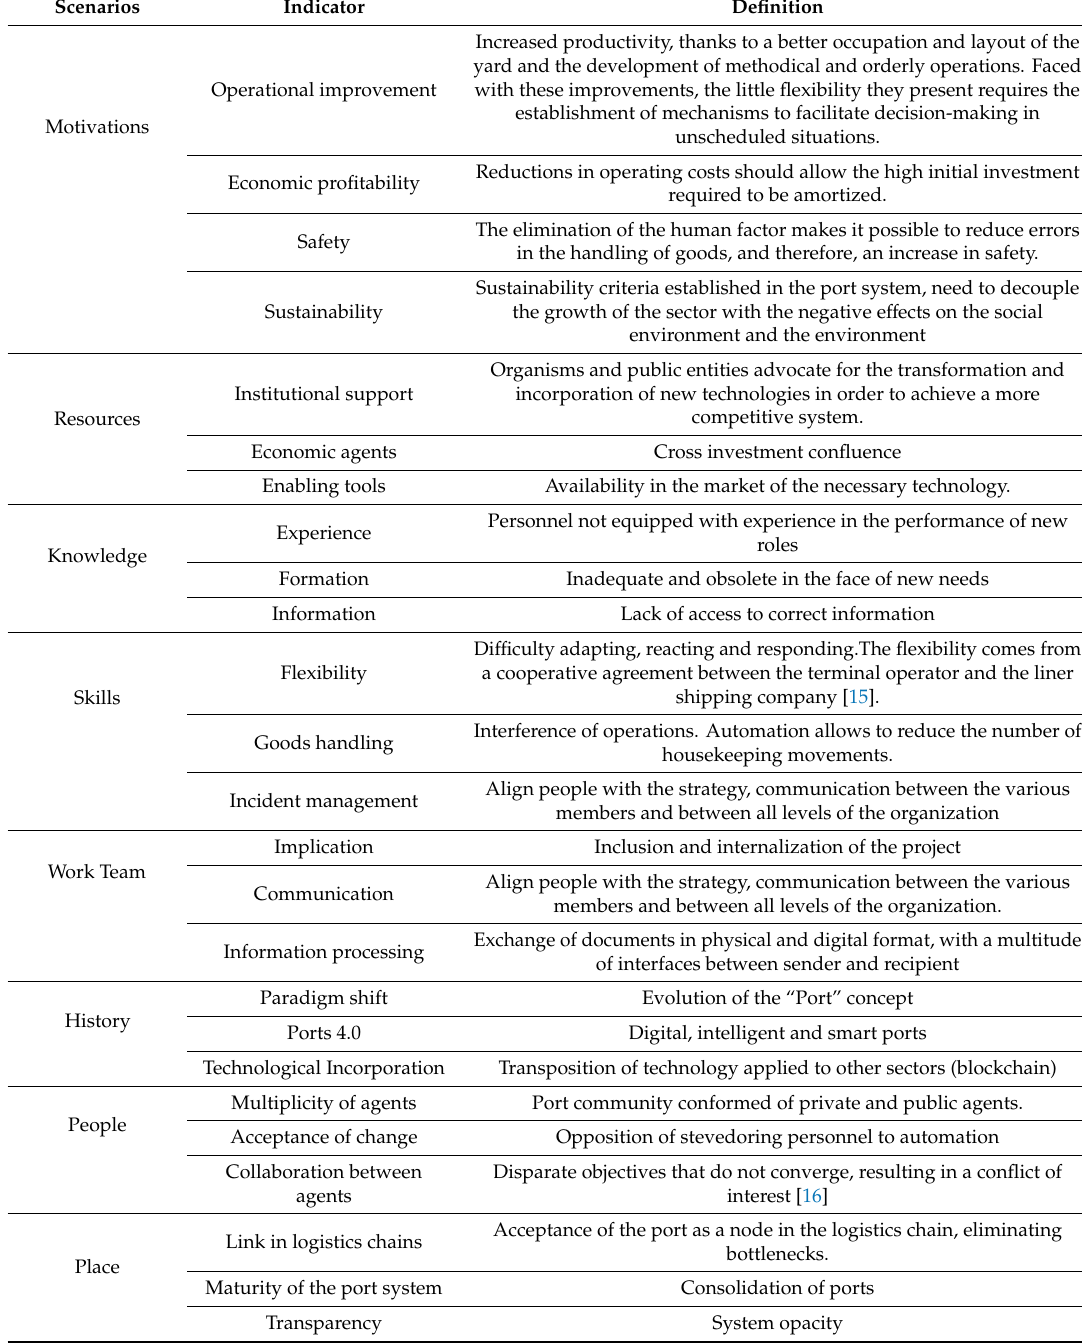
Table 2. Definition of the characterization indicators based on BOT